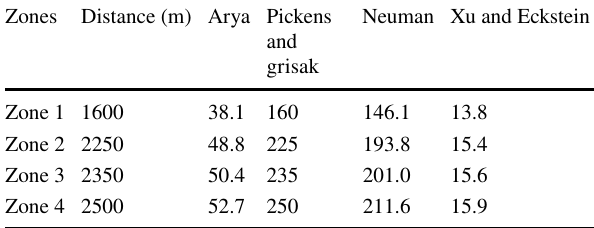
Table 2 Estimated values of longitudinal dispersivity using empirical equations Zones Distance (m) Arya Pickens